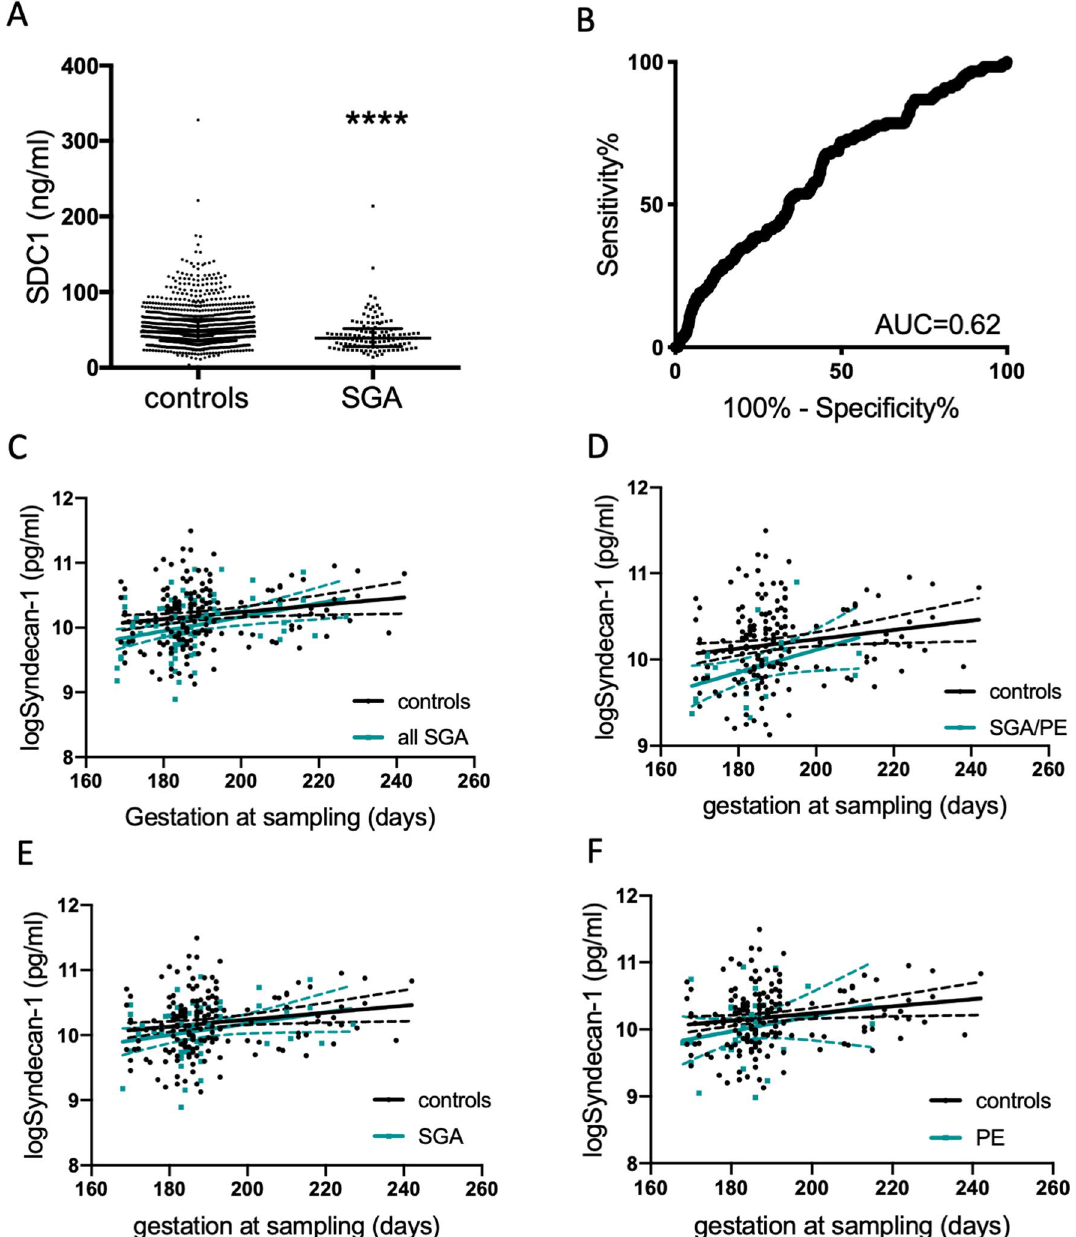
Figure 1. Syndecan-1 is reduced at 36 weeks’ gestation and in women with underlying vascular disease. In samples collected at 36 weeks’ gestation in Sydney Australia (Cohort 1, n = 1085 controls and n = 121 SGA), circulating syndecan-1 was significant reduced ( A ) with an area under the receiver operator curve (AUC) of 0.67 ( B ). Linear regression analyses of logSyndecan-1 in women who attended the Manchester Antenatal Vascular Service (MAViS clinic; Cohort 2) and had plasma sampling across 24–34 weeks’ gestation. ( C ) Controls (n = 171) and women who delivered small-for gestational age (SGA) infants (with or without preeclampsia, n = 82). ( D ) Controls (n = 171) and women who delivered with preeclampsia (PE) and had an SGA infant (SGA/PE n = 25). ( E ) Controls (n = 171) and women who delivered an SGA infant (without preeclampsia, n = 57). ( F ) Controls (n = 171) and women who delivered with preeclampsia and an appropriately grown infant (n = 32). Individual symbols represent a single patient sample. For ( A ), data expressed as median ± IQR, ****p = 0.0001. In panels ( C – F ), the solid line is the line of best fit, while the dotted line is the 95% confidence